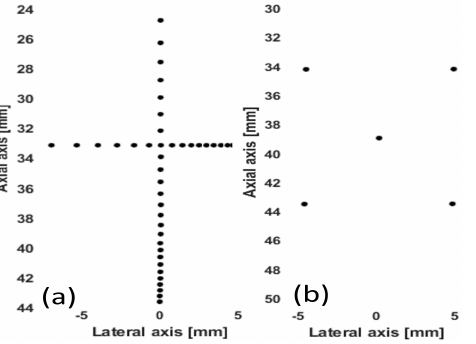
Figure 3. Studied mediums. ( a ) Simulated position of the scatterers inside the wire phantom. ( b ) Physical position of the scatterers inside the water